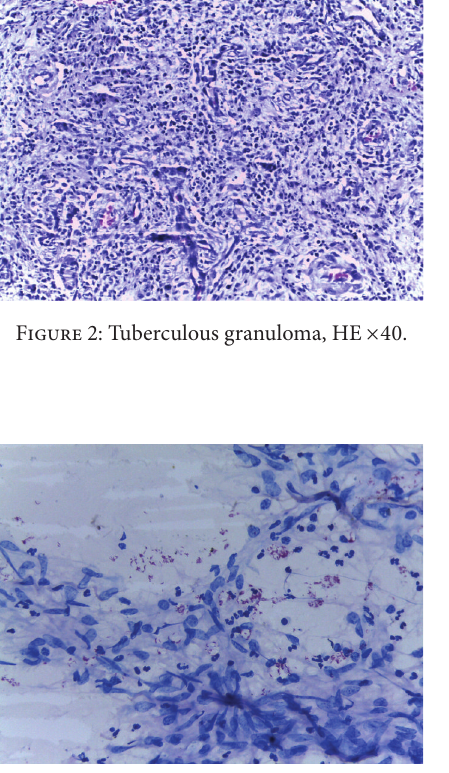
Figure 3: Special stain (ZN) for AFB ×